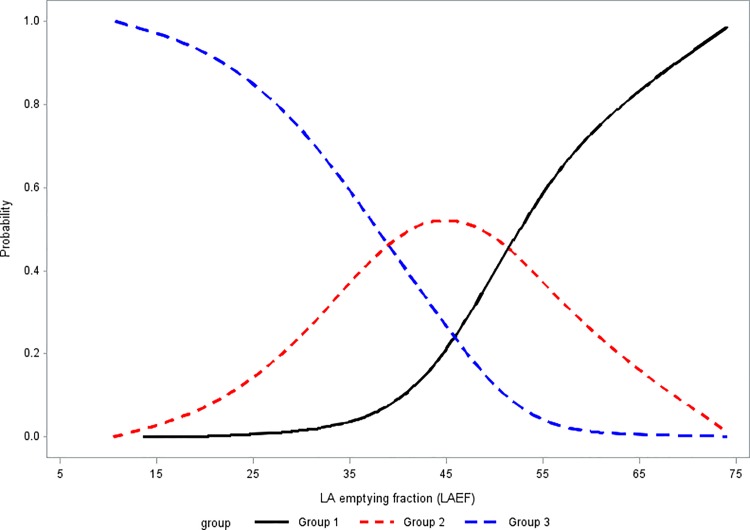
Proportional odds logistic regression on LAEF.The probability of assigning patient to group 1 is high when LAEF is high (black line); the probability of assigning patient to group 3 is high when LAEF is low (blue dashed line); and the peak probability of being group 2 is located at LAEF = 45% (red dashed line).